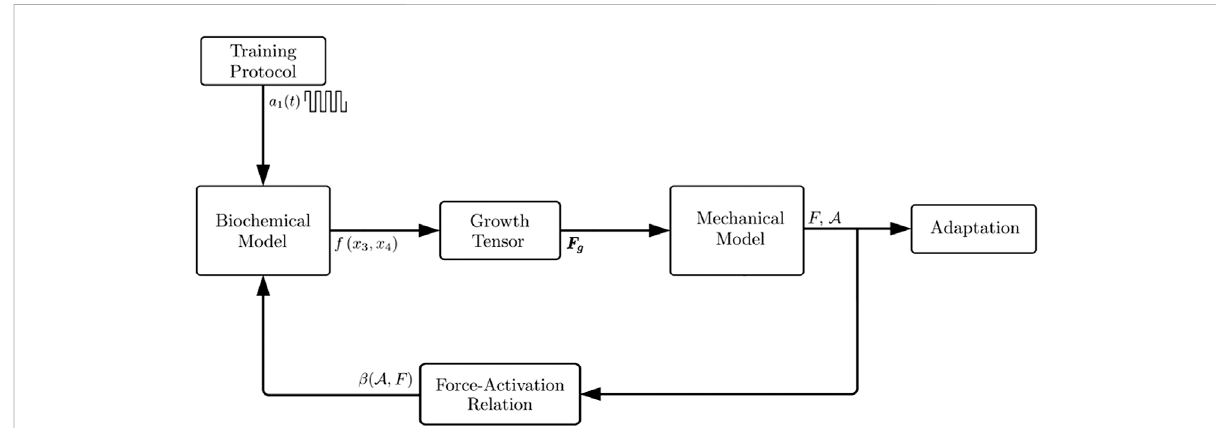
FIGURE 3 Algorithm for the mechanobiological model for muscle adaptation. Each function outside a block is an output of the closer block and an input for the next block. f is the rate of change of the myo fi bril population, F g is the growth tensor, F and A are the force and CSA of the updated muscle structure, and β ( A , F ) is the inverse function of the force-activation relation at CSA A